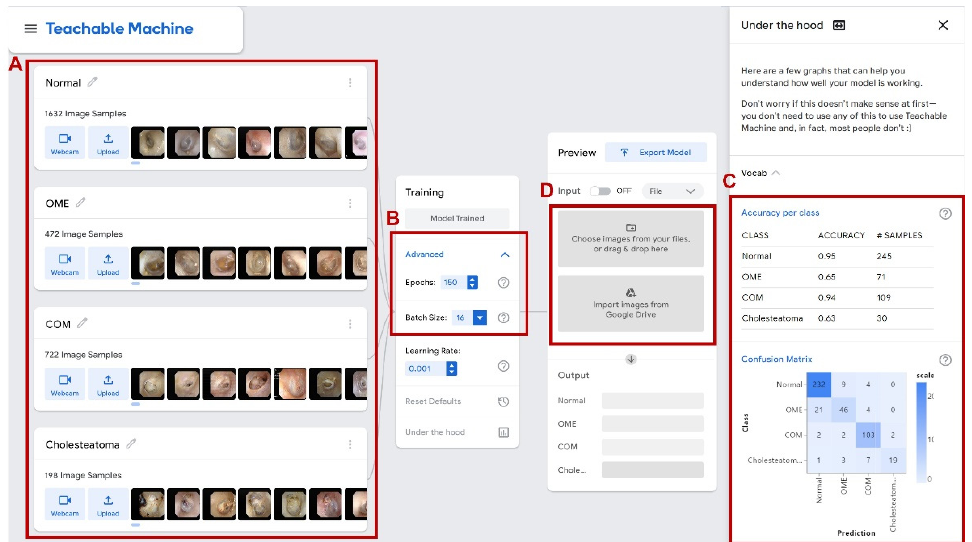
Figure 2. The Teachable Machine ® interface ( A ). Image classification, ( B ). Hyperparameters of epoch and batch size, ( C ). Accuracy per class and confusion matrix with validation set data. ( D ). Input of photo of tympanic membrane to check result of the machine learning network.